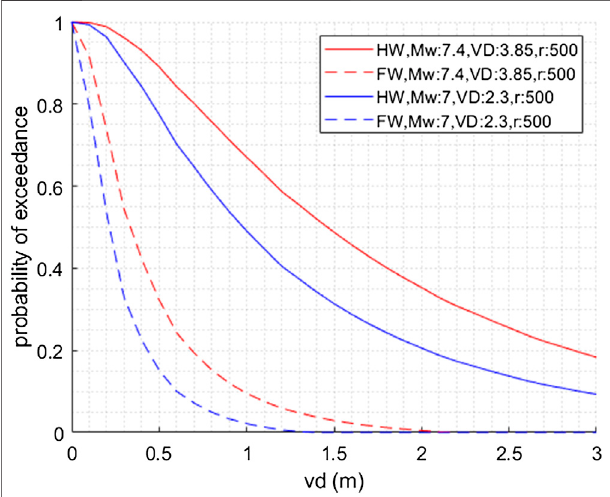
FIGURE 11 | Curves for the probability of exceedance for given vertical displacementlevelsforhangingwall(HW;solidlines)andfootwall(FW;dashed lines)forM w 7(bluelines)andM w 7.4(redlines)atasitein500 mdistancefrom the